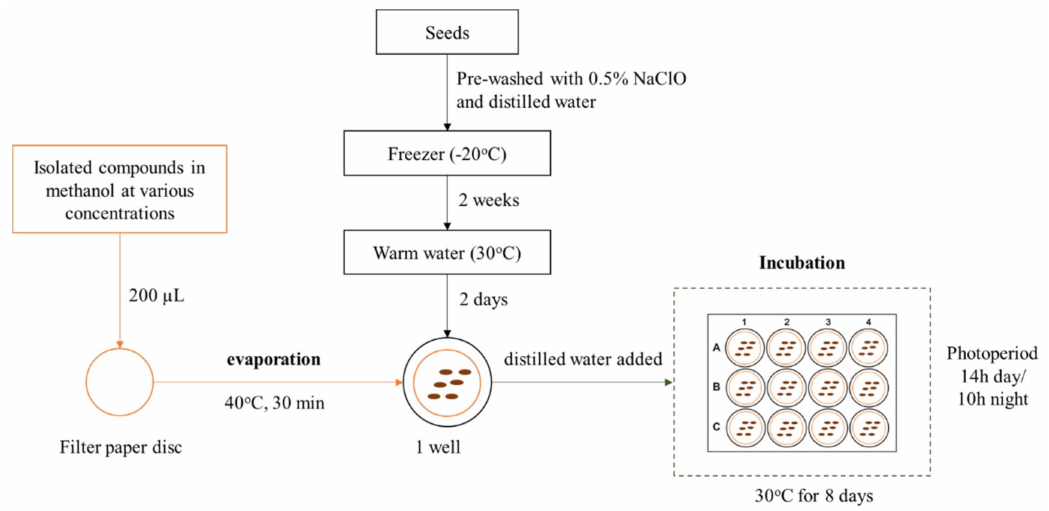
Figure 2. General experimental design of the in-vitro allelopathic